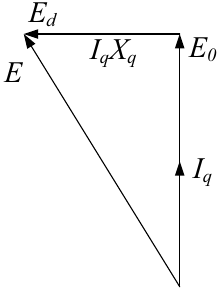
Figure 6. Phasor